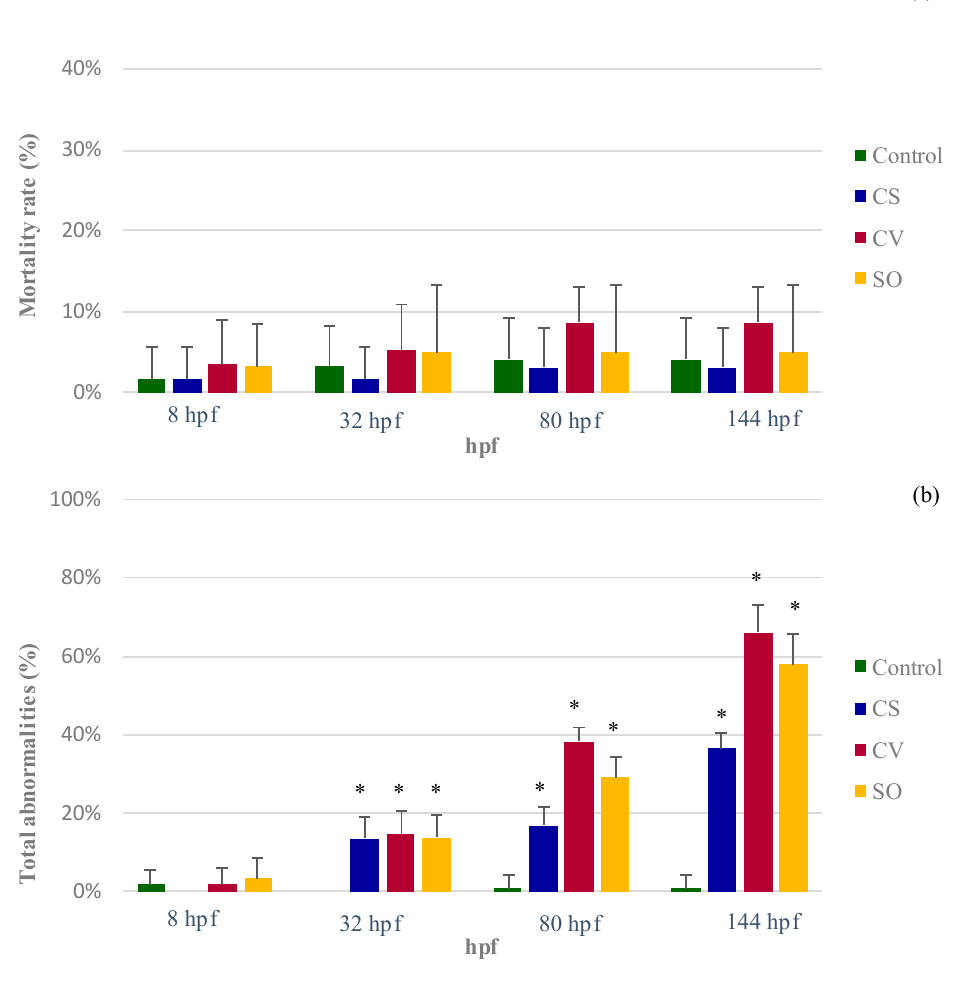
Figure 3. Mortality ( a ) and total abnormalities ( b ) observed for zebrafish embryos exposed to effluents from microalgae treatment for the removal of acetaminophen from water. Results are shown at the different observation times (8, 32, 80 and 144 hpf) for CS, CV and SO microalgae treatment. Note: Mean results ( n = 12 for control; n = 6 for exposed groups) are shown together with SE. Results significantly different from control ( p ≤ 0.05) are marked with a symbol (*). In Figure 3a, the scale of the vertical axis was fitted (from 0% to 50%) for the visualization of results.